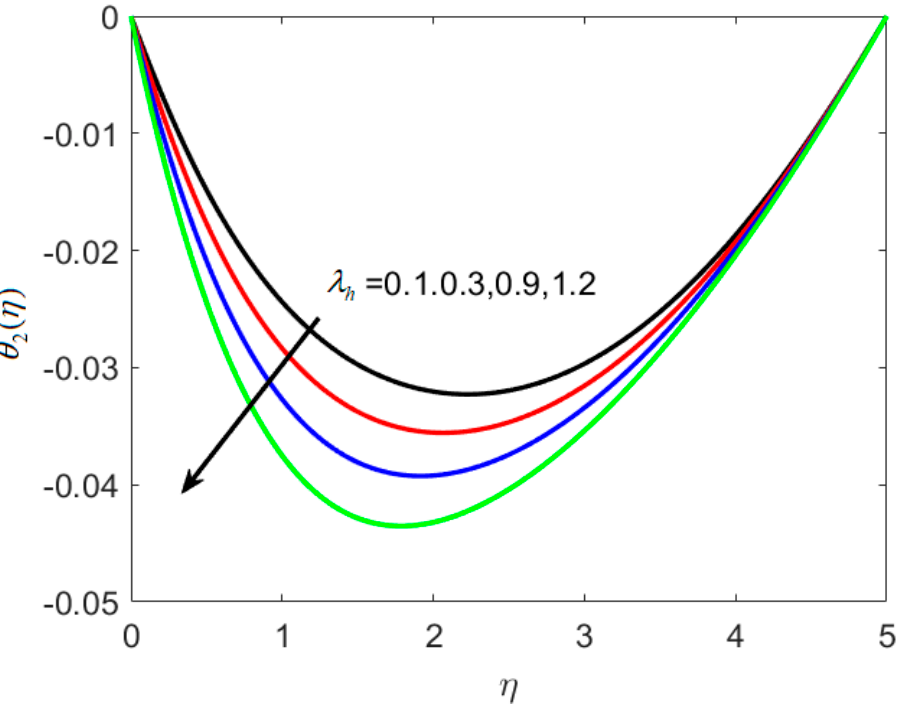
Figure 4. Different estimates of thermally stratified parameter S t by taking B 1 = 1.2, B 2 = 1.3, λ h = 0.1, N c = 0.3, N t = 0.2, γ = 0.2, κ ∗ = 0.1, Le = 0.2, δ = 0.3. 1 Figure 5 illustrates the consequence of the thermal relaxation time parameter λ h on θ 1 ( η ) . As seen in Figure 5, a decrease in temperature is noticed with increases in ( λ = 0.3, 0.5, 0.9, 1.2 ) (thermal relaxation time parameter). Because of the extended thermal h relaxation period, the fluid temperature drops. This effect necessitates additional time for heat to be transported to nearby particles, which gives rise to magnetohydrodynamic interactions, and heat transfer reduces.